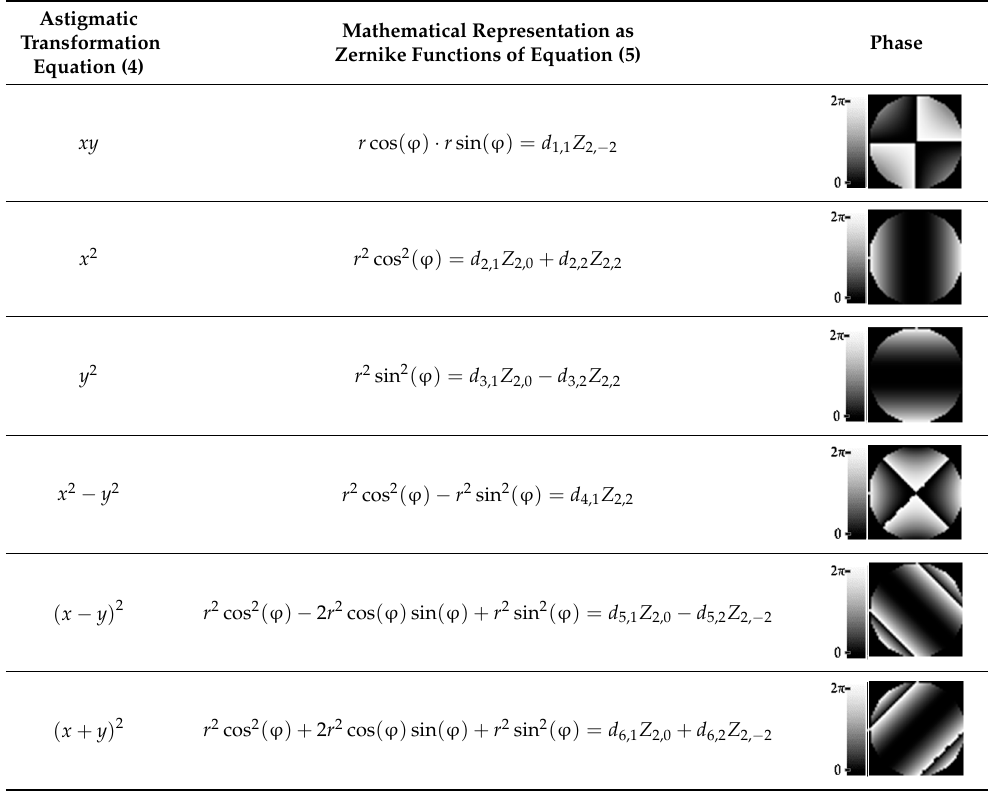
Table 2. Correspondence of some types of astigmatic transformations of Equation (4) and Zernike functions.